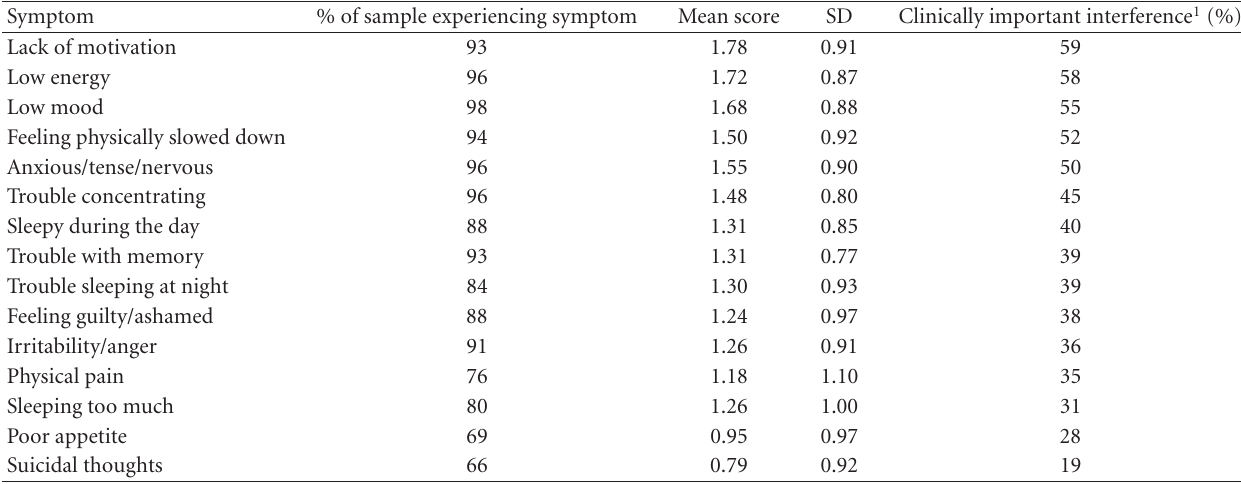
Table 2: Summary of responses ( N = 164) from questionnaire relating symptoms to interference with work functioning. Symptom